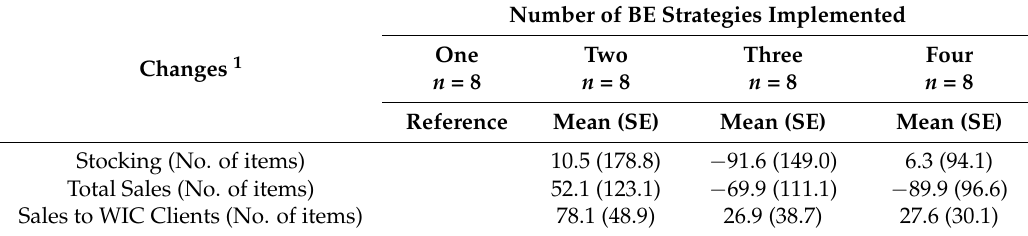
Table 5. Changes in the stocking of WIC-eligible foods, total unit sales of WIC-eligible foods to all customers, and unit sales of WIC-eligible foods to WIC clients in intervention stores following implementation of two, three, and four BE strategies, all food groups combined. Number of BE Strategies Implemented One Two Three Changes 1 n = 8 n = 8 n = 8 Reference Mean (SE) Stocking (No. of